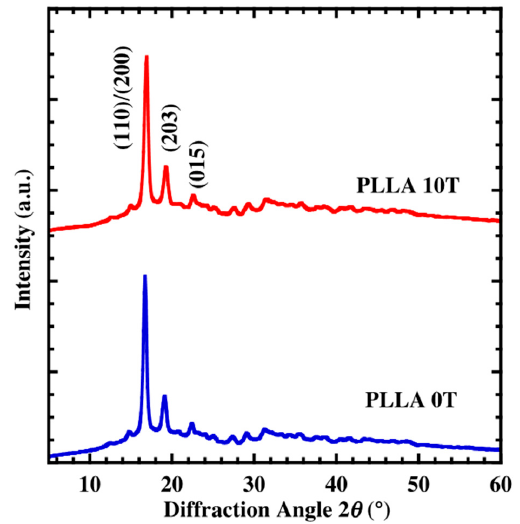
Figure 1. XRD patterns of PLLA10T and PLLA0T films.